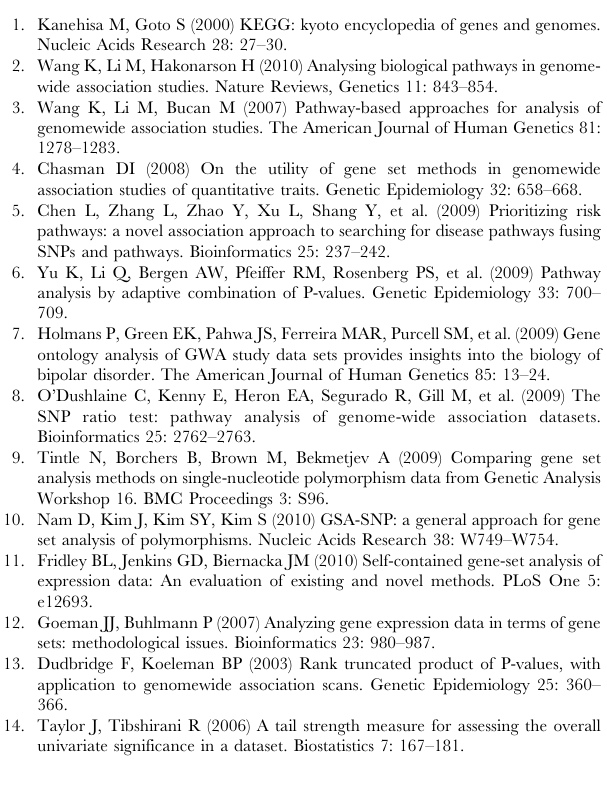
Table S1 Type-I error rates and power of the methods for the various scenarios tested in the simulation study. Table S2 Pathways identified as enriched by the five methods for BMI phenotype. Table S3 Pathways identified as enriched by the five methods for the four endpoints of platelet